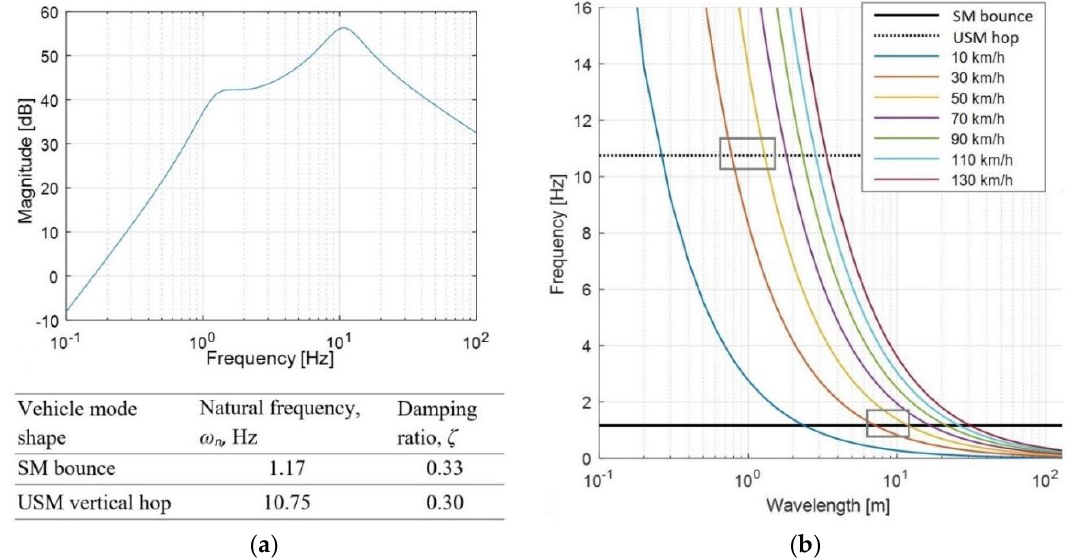
Figure 9. Sensitive vehicle frequencies of pavement wavelengths: ( a ) Natural frequencies and damping ratios of the Bode plot; ( b ) wavelength frequency characteristics conforming to driving speed.